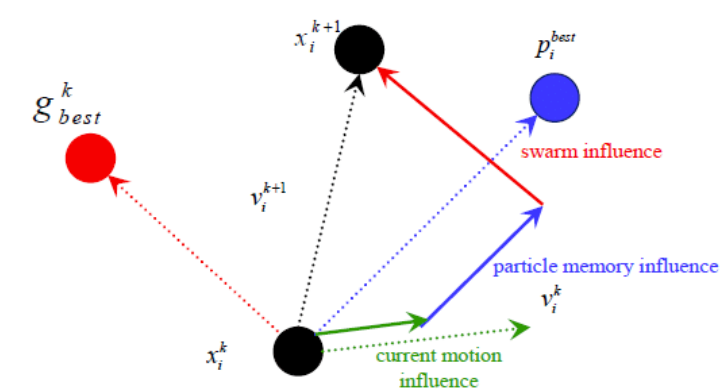
Figure 5. PSO particle behavior flow chart.